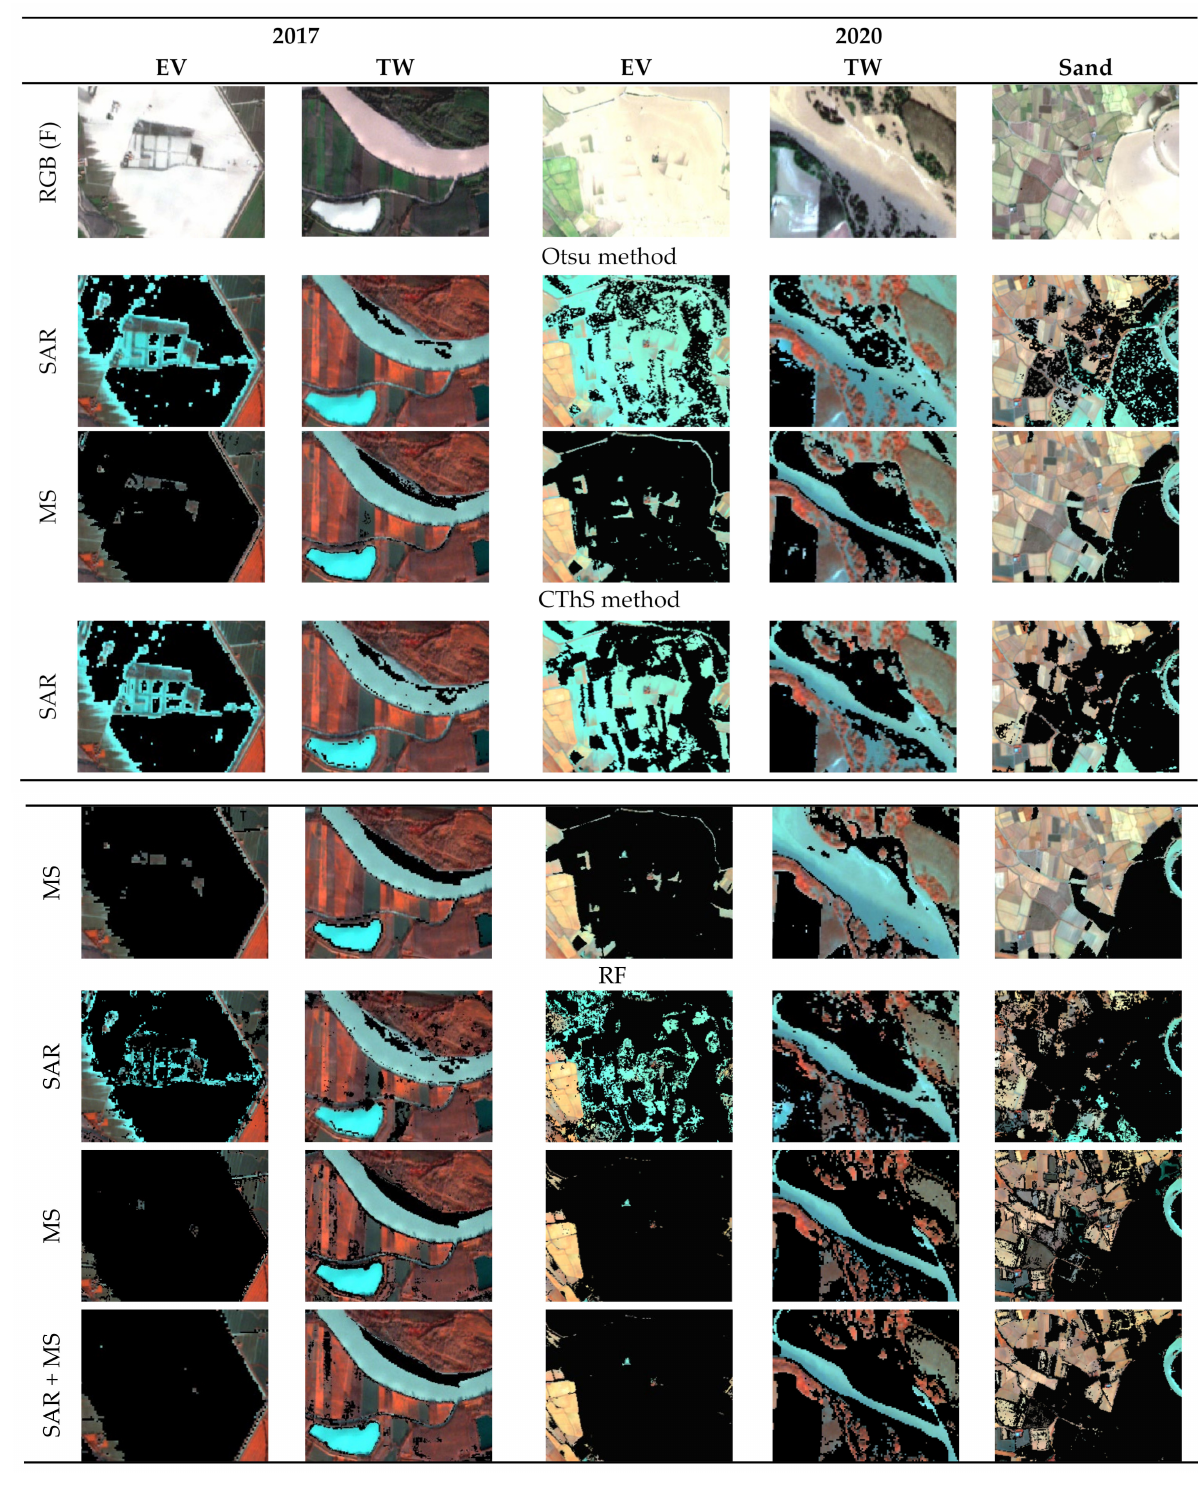
Figure 14. Flood maps of EV: emergent vegetation, TW: turbid water, and sand for all the experiments in 2017 and 2020. Pixels classified as water are displayed in black color, overlaid onto the NIRGB false color composite of the flooding dates. The light blue patches correspond to the river, which was masked out from the flooding water maps (Figure 2). The first row shows the pictures of RGB true color composite of flood conditions; 13 December 2017 and 03 October 2020. The backscatter data on 7 December 2017 and 27 September 2020 as well as the MS data on 24 October 2017 and 9 August 2020 were used to map the permanent water body areas by each method